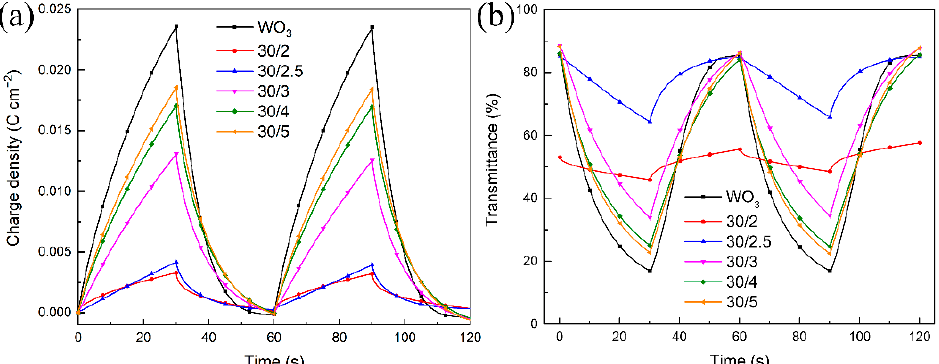
Figure 8. The variation of CC curves ( a ) and the corresponding transmittance ( b ) of ITO/WO 3 /TaO x with different Ar/O 2 ratios.